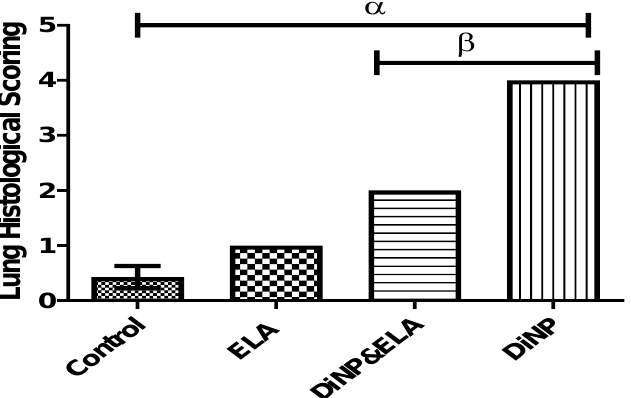
Figure 8 Histological Scoring of Lungs Pathology Following Hematoxylin and Eosin (H and E)